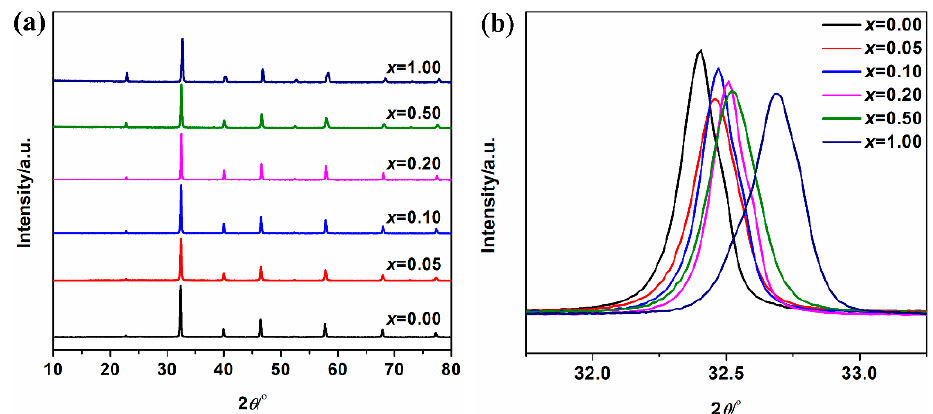
Figure 1. ( a ) XRD patterns of the SrLaTiCrO- x samples with x equal to 0.00, 0.05, 0.10, 0.20, 0.50 and 1.00. ( b ) Detailed XRD patterns around the strongest diffraction peaks (121) in the 2 θ range from 31.75 to 33.25 o .